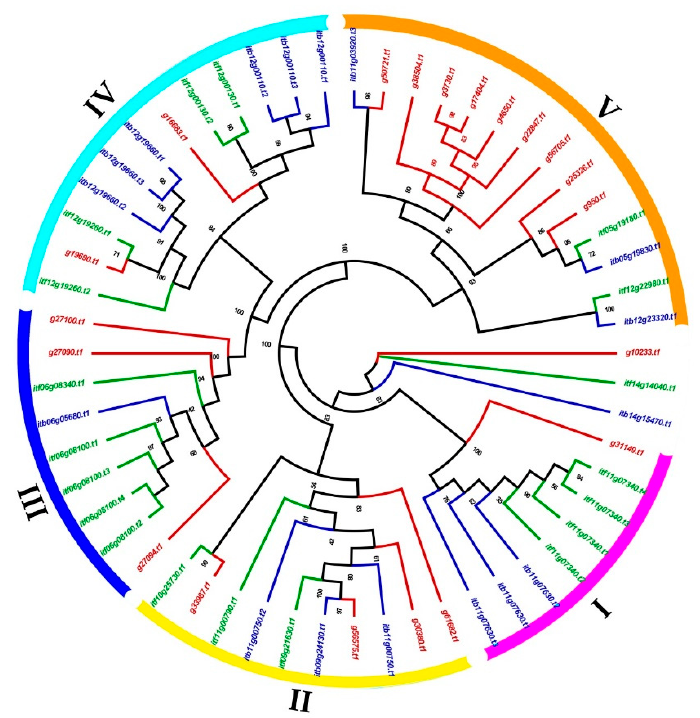
Figure 1. Phylogenetic relationships of the nifH genes in sweet potato, I. trifida and I. triloba based on the amino acids. Red, green and blue lines represent the nifH genes in sweet potato, I. trifida , and I. triloba , respectively.